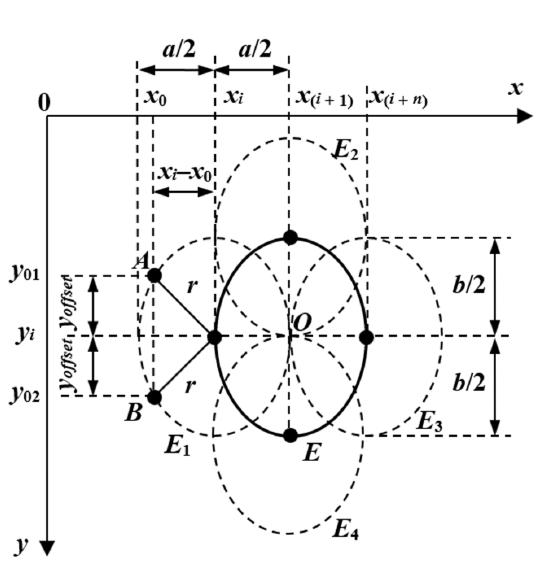
Figure 6. Elliptical Hough transform principle.